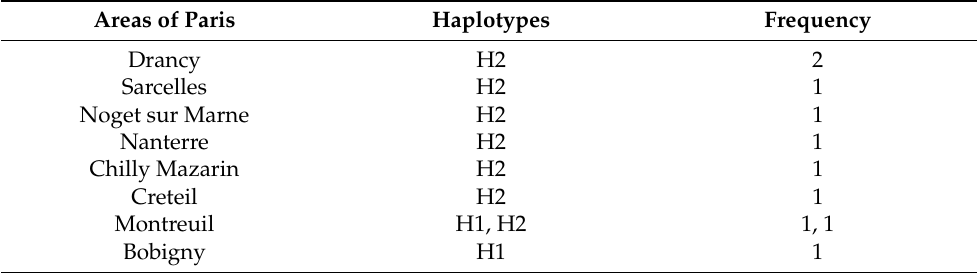
Table 2. Cont. Areas of